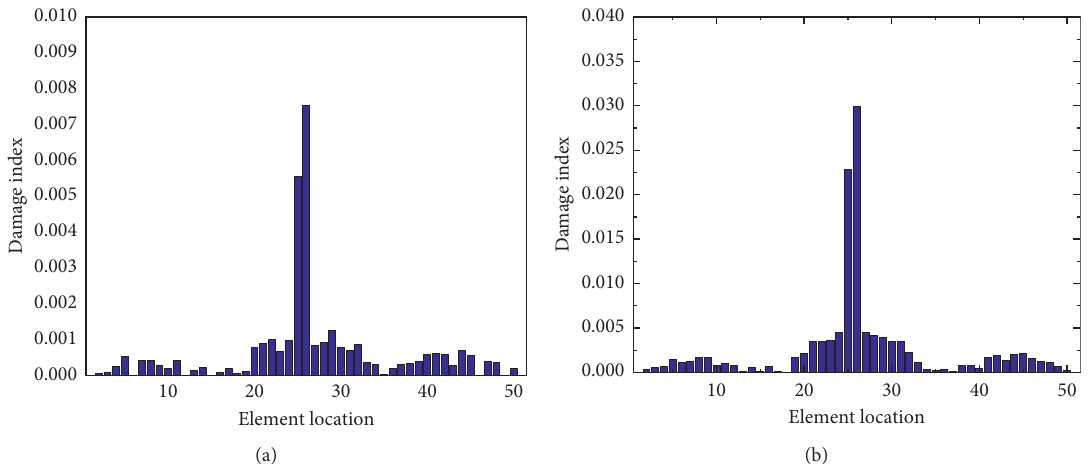
Figure 10: Damage detection results of single damage cases. (a) Case study 5. (b) Case study 6.